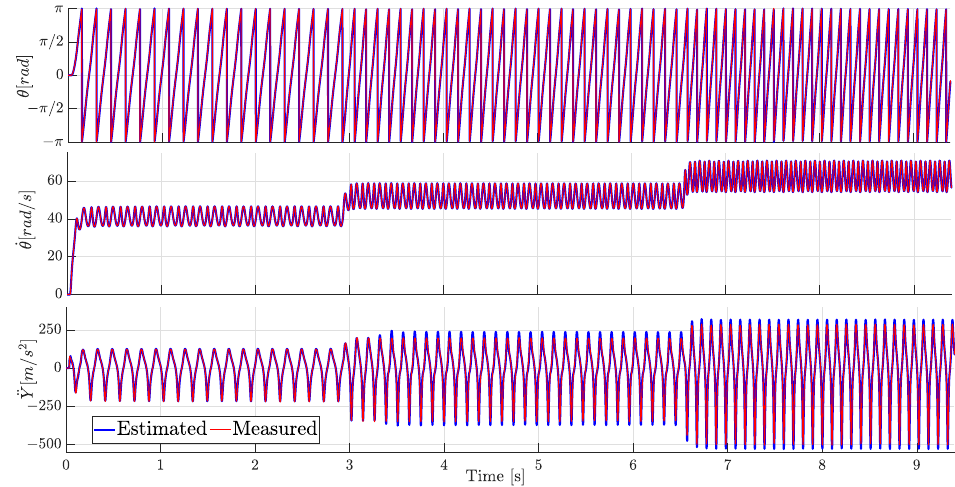
Figure 6. Comparison of the measured and estimated motor angle θ ( top ), motor angular velocity ˙ θ ( middle ) and translational slider acceleration ¨ Y ( bottom ) for the full time series.